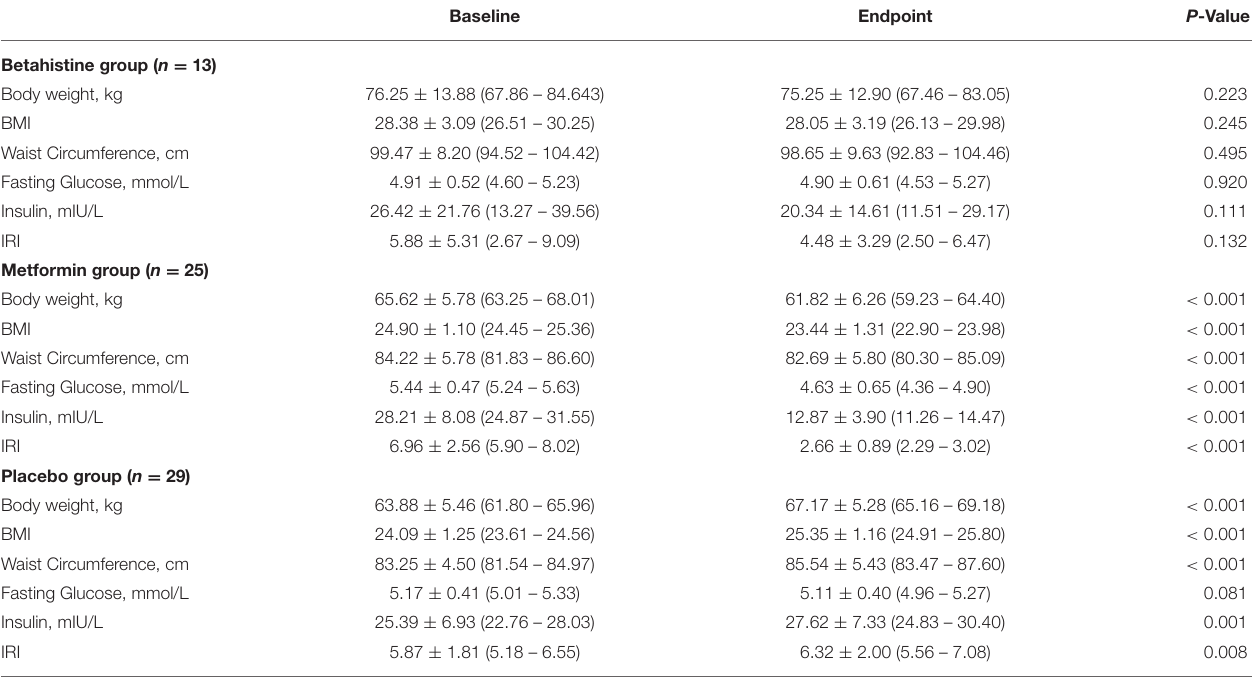
TABLE 2 | Treatment outcomes for all 67 participants.